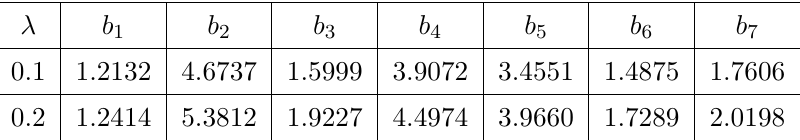
Table 2 . The b i coefficients of the function c